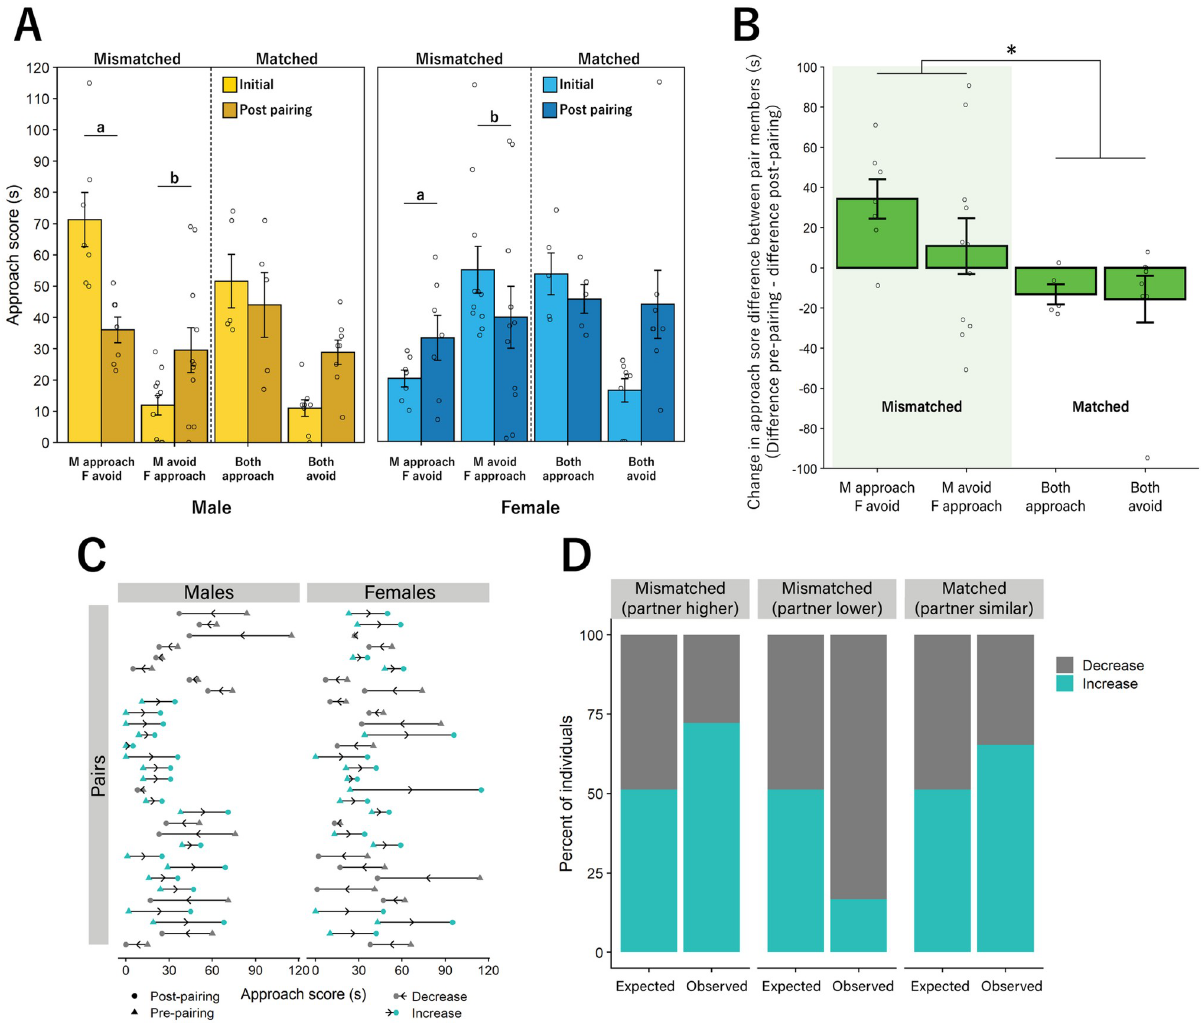
Fig 3. Pairs increased similarity in approach to bark call playback. A . Both male (left) and female (right) mismatched pairs altered their approach scores post pairing to become significantly more similar to their partner while matched pairs showed no significant difference in approach across the two time points. B . Mismatched pairs (left) showed a significant change in difference score between pairs from pre-pairing to post-pairing testing compared to matched pairs. C . Plots of individual changes in approach from pre-pairing test to post-pairing test. Increased approach scores are denoted by blue circles, while decreased approach scores are denoted by gray circles. D . The number of individuals that increased or decreased their approach score post pairing, compared to expected values based on random change in approach behavior. Members of mismatched pairs were more likely to systematically increase or decrease their approach score to match that of their partner, while matched pairs did not vary from expected outcomes. (a, b, � = p < 0.05). Significant lower-order effects were not indicated for any analyses. Bar graphs represent Mean +/-